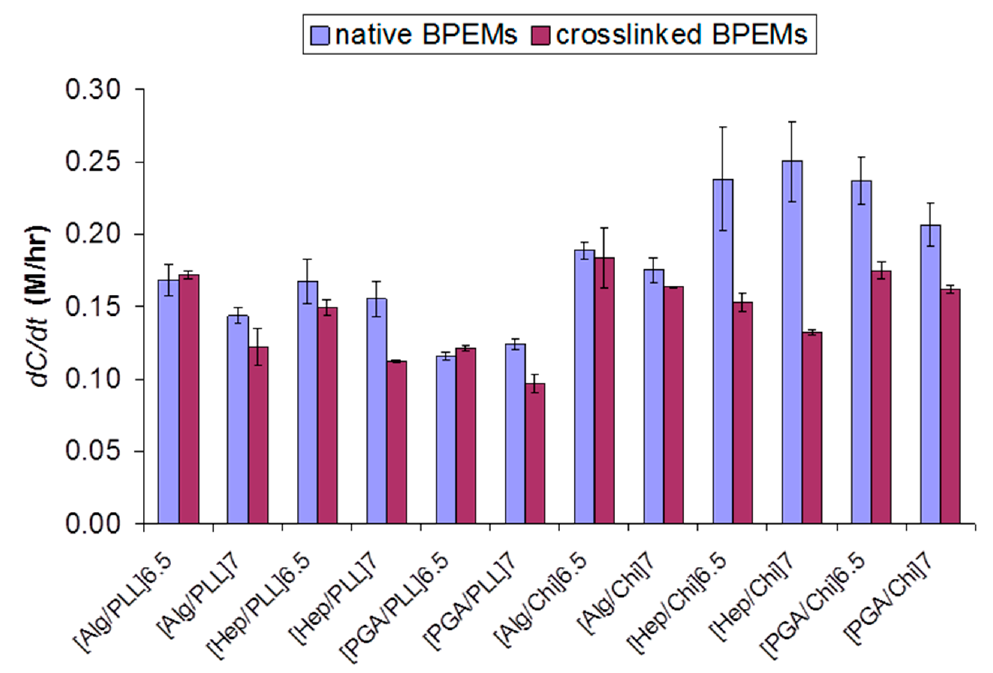
Figure 5. Permeation rate ( dC / dt ) of glucose through various BioPEMs before and after chemical crosslinking. Error bars indicate 95% confidence intervals (n = 3). Table 2. Diffusion coefficients (D) of glucose through various BioPEMs.